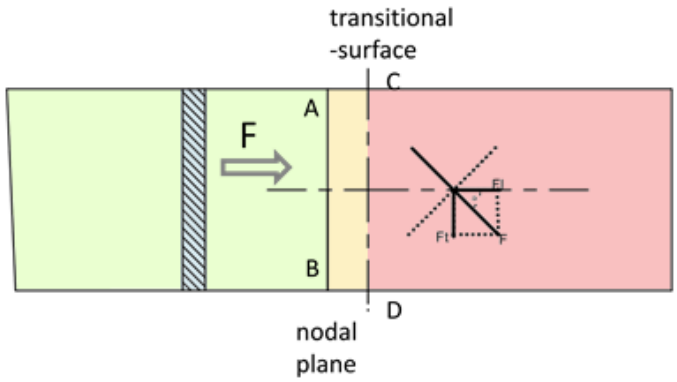
Figure 3. Schematic diagram of vibration propagation.